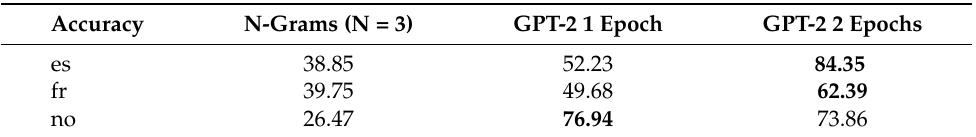
Table 10. Template selection average accuracies per language. The models are different for each language and also the number of candidates per task. Results for all tasks can be found in Table A2 of Appendix B. Bold values indicate the best results for each language.